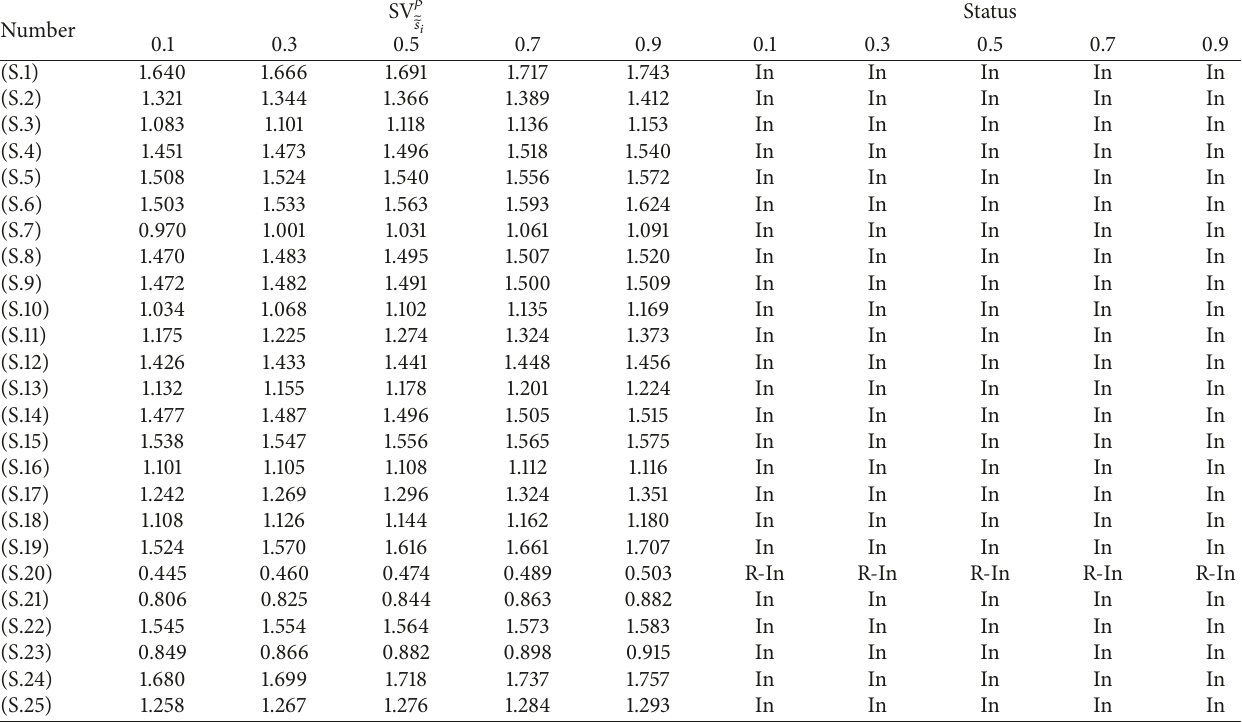
Table 2: Process variability